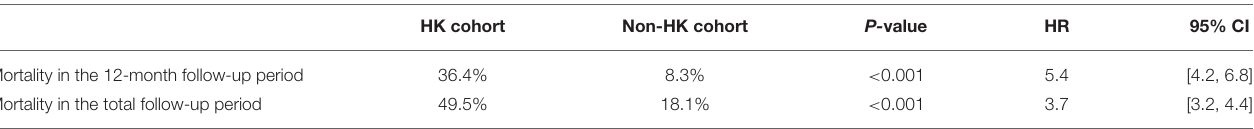
TABLE 2 | Mortality of the HK and non-HK cohorts during the follow-up period.